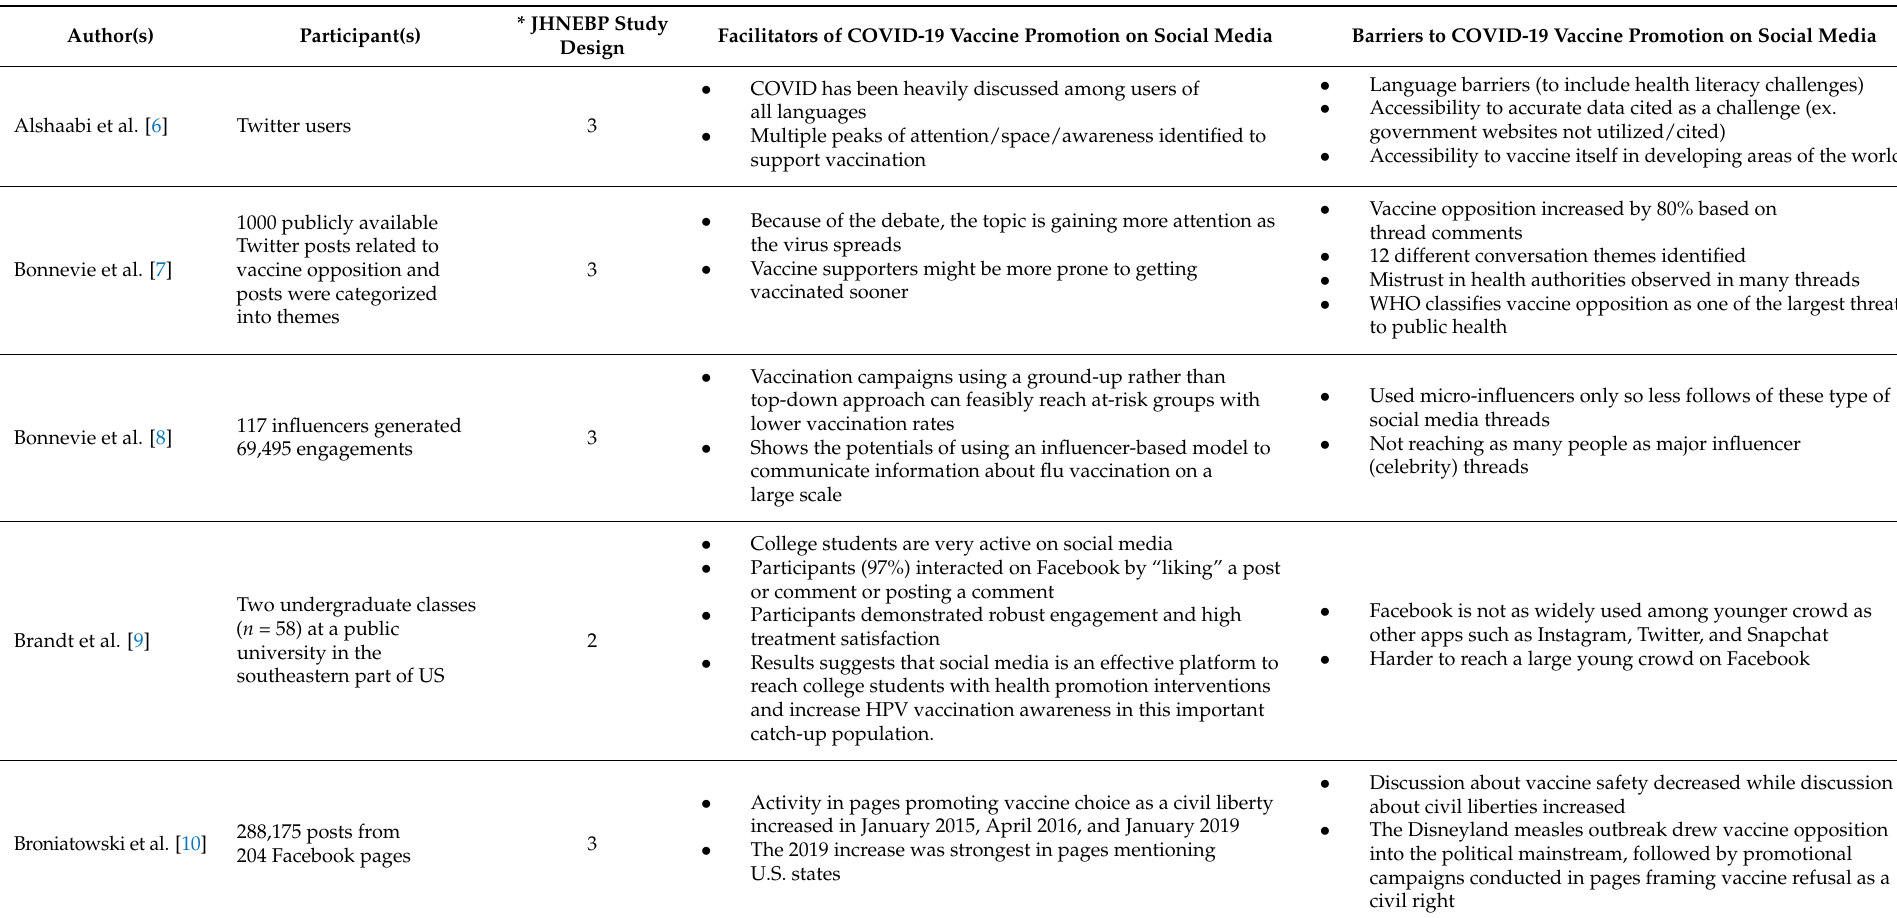
Table 2. Summary of Findings ( n =